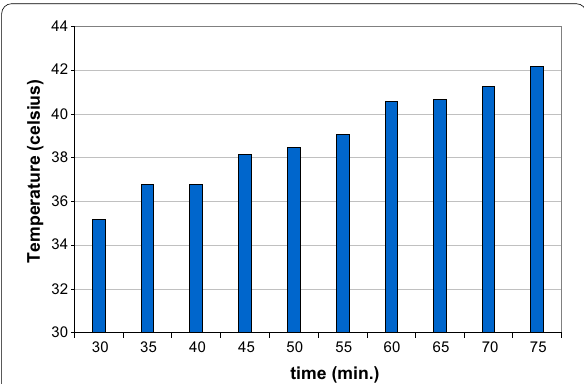
Fig. 6 Temperature vs. time (30 min. up to 75 min), by using brackish groundwater in case of closed cycle at flow rate of 52.16